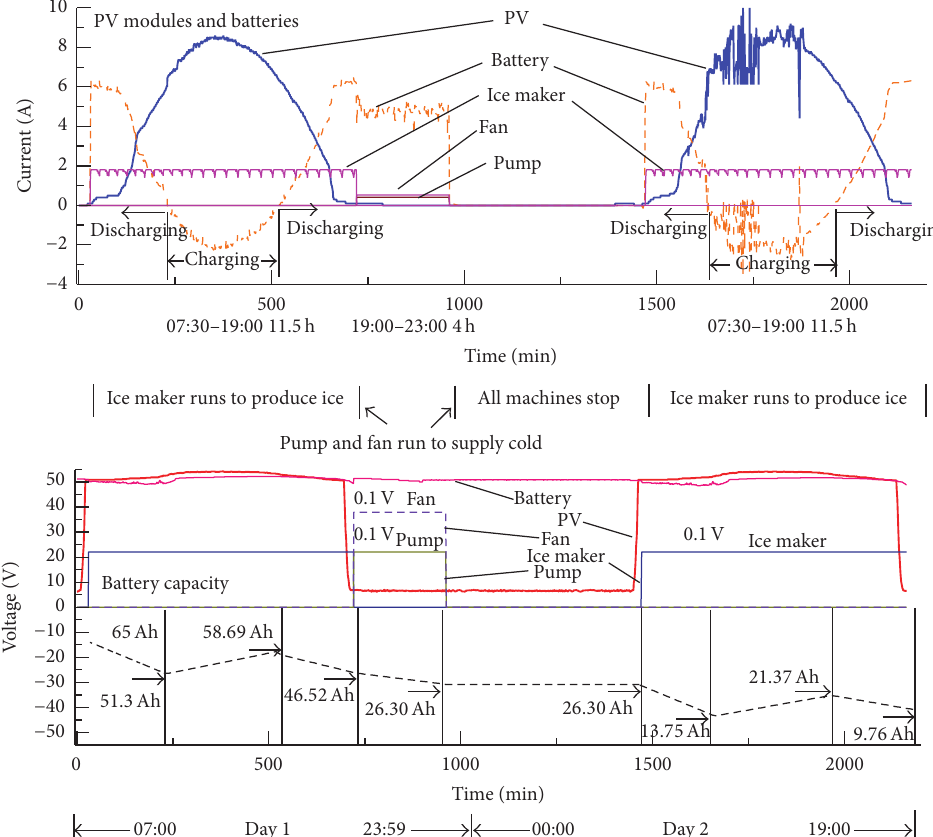
Figure 11: The conversion and flow characteristics of power generated by PV modules among batteries, ice maker, and air conditioning system.